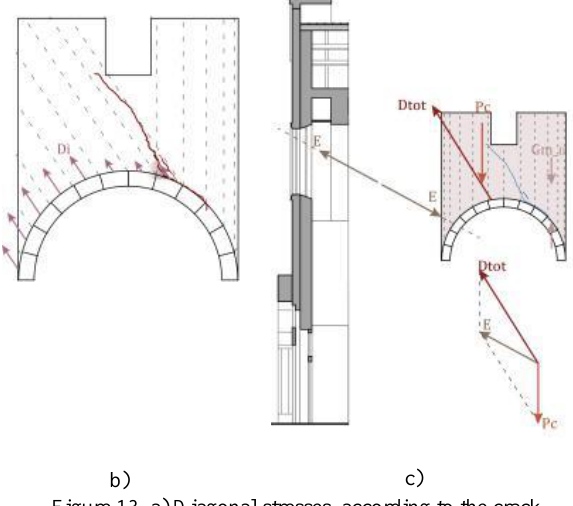
Figure 13. a) Diagonal stresses, according to the crack observed, obtained through the Mohr Circle, b) Diagonal